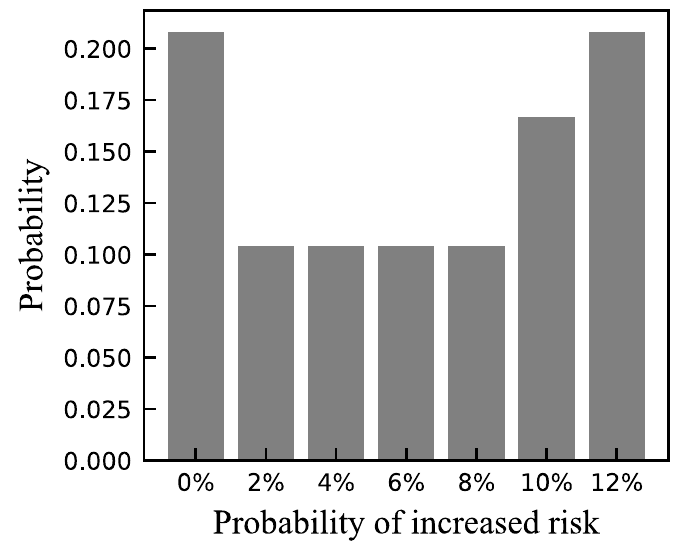
Figure 3. The distribution of the risk results.